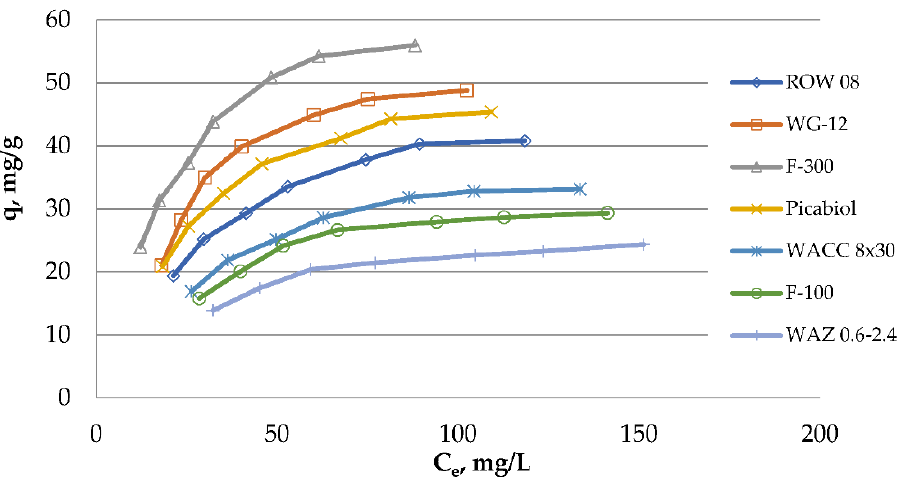
Figure 4. Oxytetracycline adsorption isotherms on tested activated carbons; pH = 6.